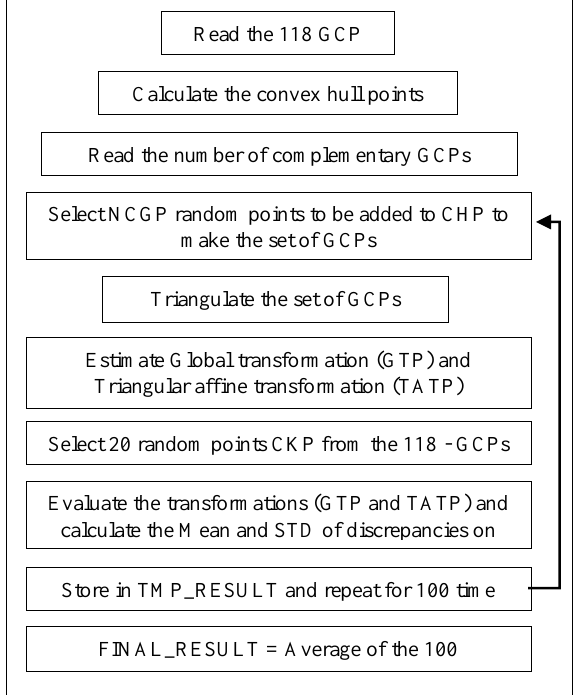
Figure 6. Organigram of the evaluation procedure